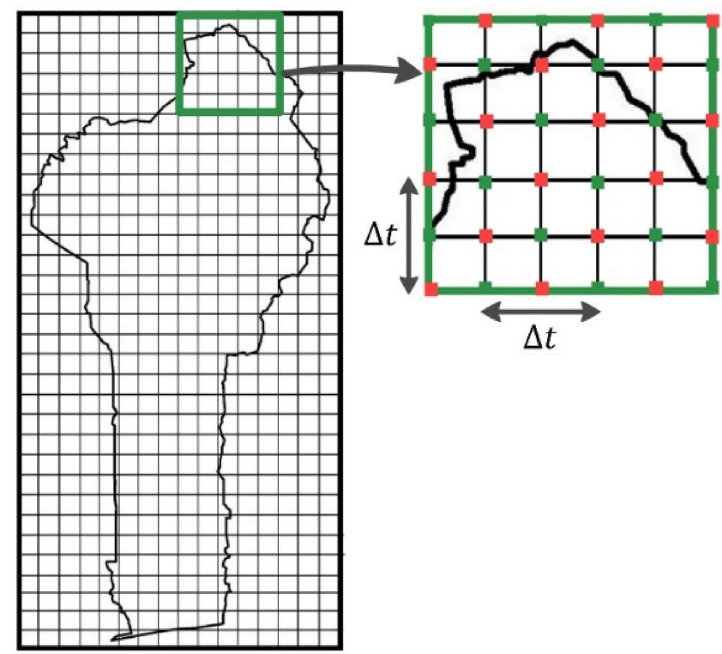
Fig. 2 Gridded and sampled map of